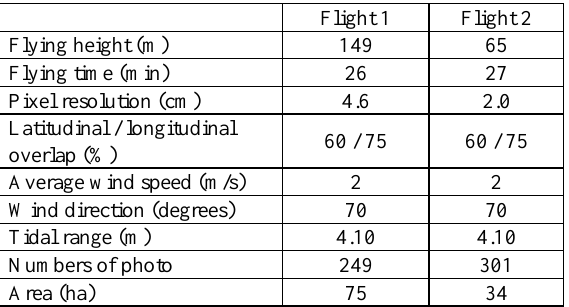
Table 1. Characteristics of the shoots and environmental